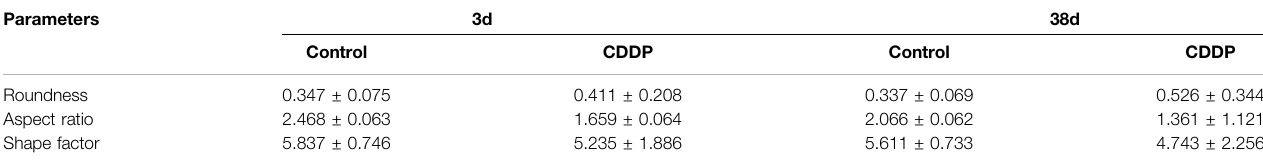
TABLE 2 | Contour measurements of mitochondria.